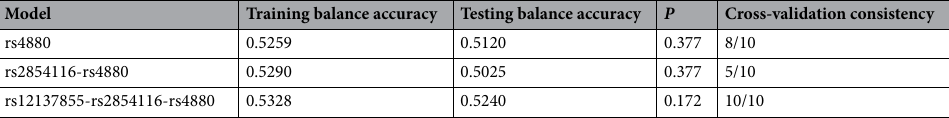
Table 8. Analysis of the GMDR model of gene–gene. Adjusted variables included: Smoking status, drinking status, DASH diet score, physical activity level, sleep quality, BMI, hypertension, HUA, shift work situation, and OS.